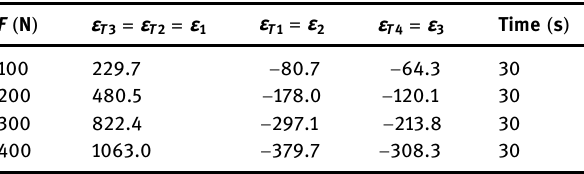
Table 2: Values of Young ’ s modulus of samples from composite